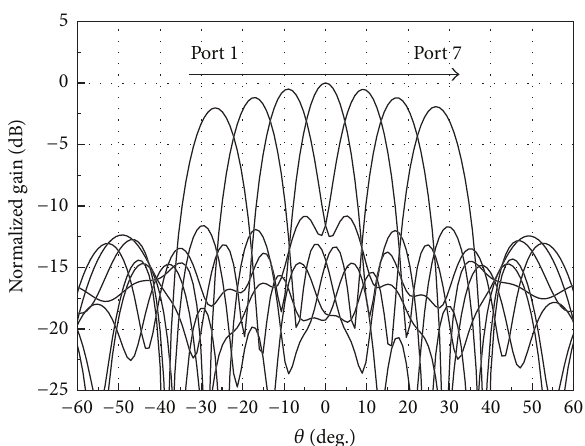
Figure 12: Radiation patterns of antenna array excited by amplitude and phase distributions of the Rotman lens at 12.5GHz for V-